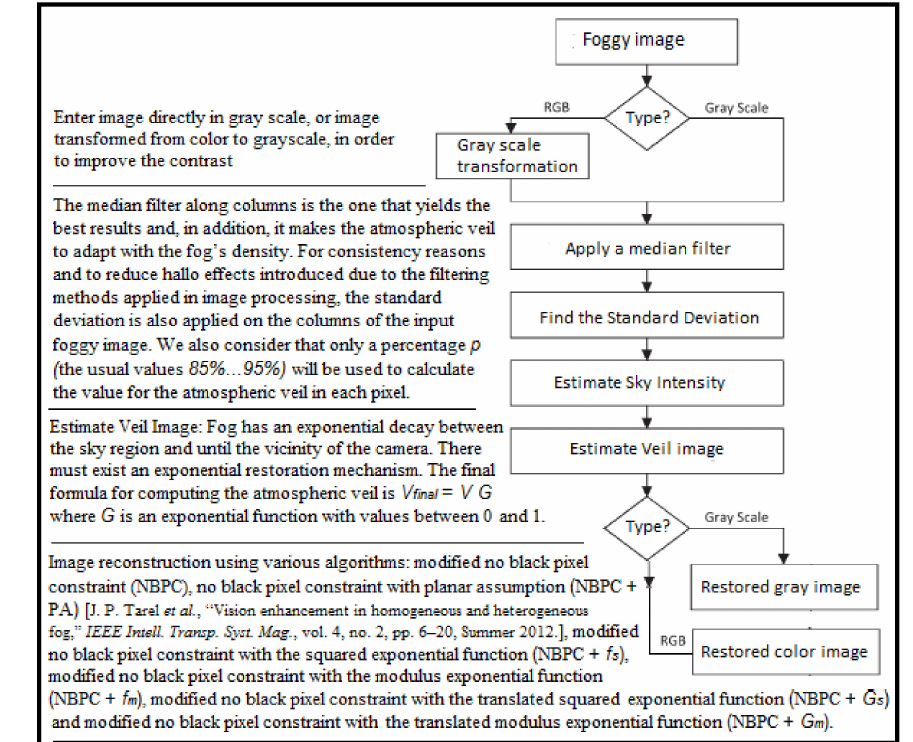
Figure 3. Method proposed in